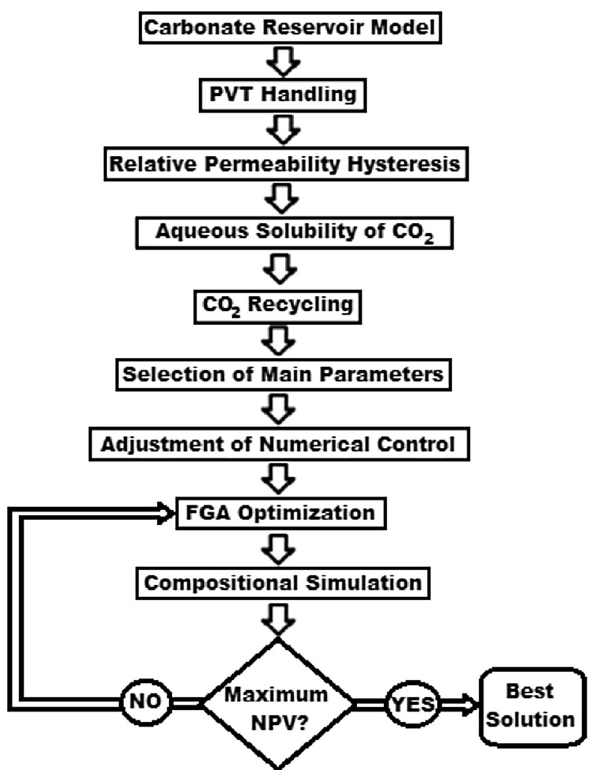
Fig. 1 Flowchart of the general methodology